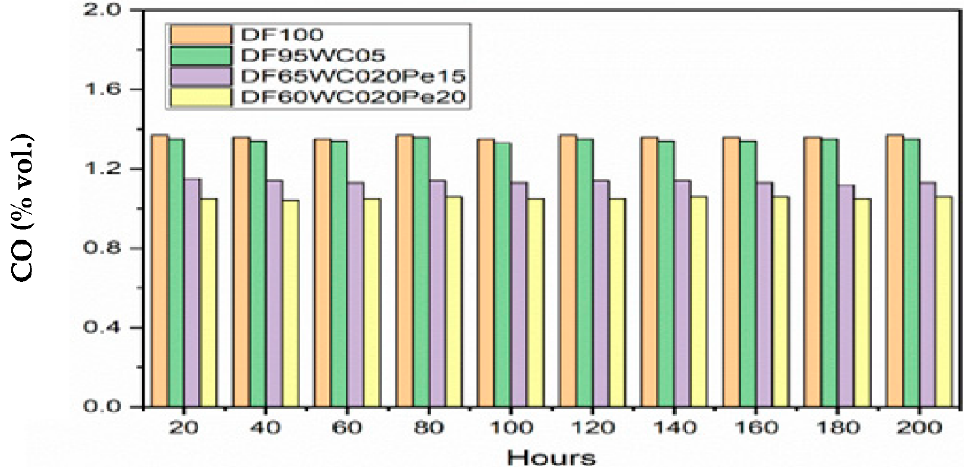
Figure 5. Carbon monoxide emissions versus engine running